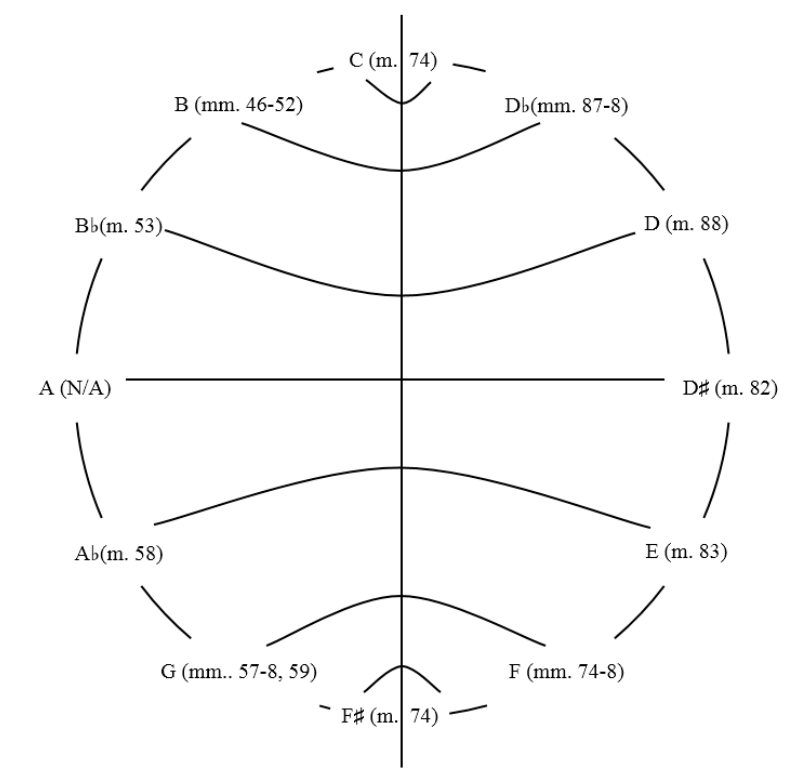
Figure 4. Macklay, Many Many Cadences , measures 46–88, harmonic progression showing both non ‐ duplicative successions of chordal roots, as well as simultaneous symmetrical and functional arrangement of triadic harmony around C and F ♯ as the poles of axis 0–6 and the first and last pitches, respectively, of normal form pitch sets [0,1,6], [0,5,6], and [6,e,0]. ( a ) Beginning of measures 46–88, viola and cello excerpted from composer’s score in which Macklay herself provides Roman numeral analysis for reference; ( b ) Measures 46–88, lower textural layer; ( c ) Measures 46–88, composing ‐ out of inversional axis.